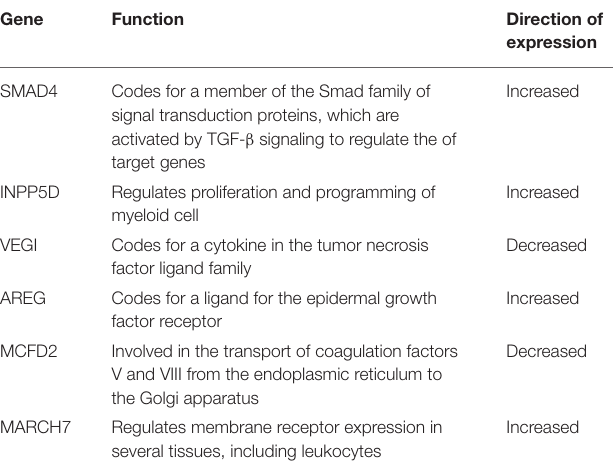
TABLE 8 | Leukocyte genes associated with HT in patients with ischemic stroke. Gene Function Direction of